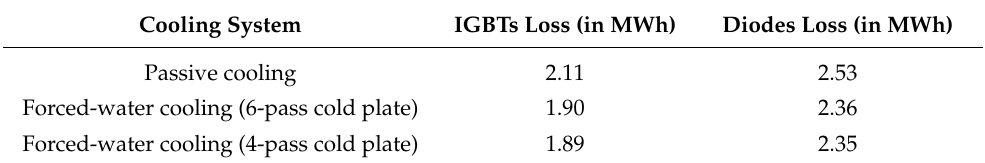
Figure 19. Comparison of mean junction temperatures between different cooling systems as a function of tidal stream velocity. Data for passive cooling is taken from mbox[2]. Table 6. Annual loss in the generator side converter for passive and active cooling systems, without waves.